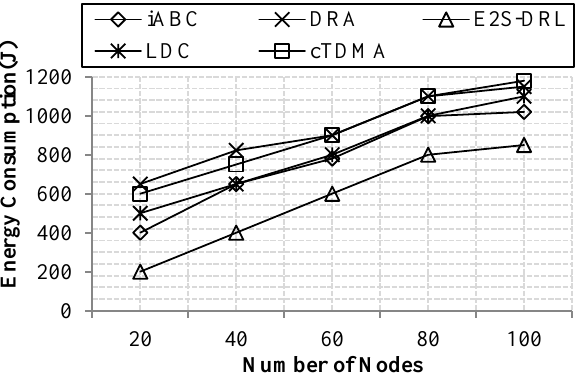
Figure 6. Comparison of energy consumption vs. the number of nodes.